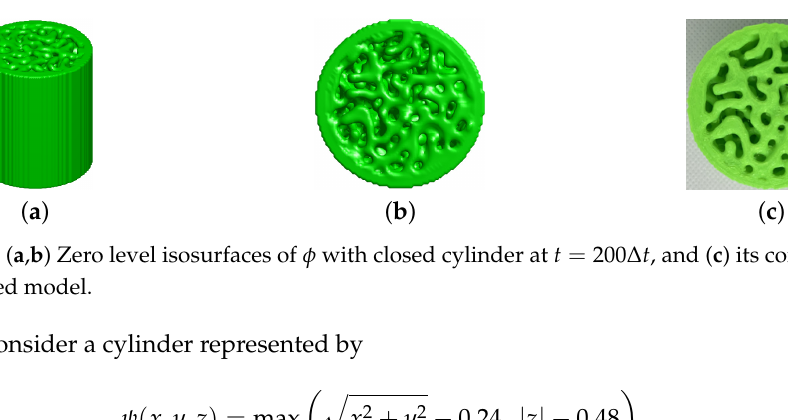
Figure 5. Zero level isosurfaces of φ at ( a ) t = 20 ∆ t , ( b ) t = 50 ∆ t , and ( c ) t = 200 ∆ t . ( d ) 3D printed model of zero level isosurfaces of φ at t = 200 ∆ t .